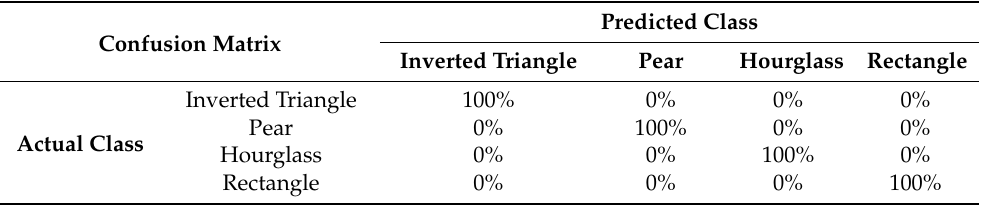
Table 3. Confusion matrix for the classification of 4 body shapes using the CNN